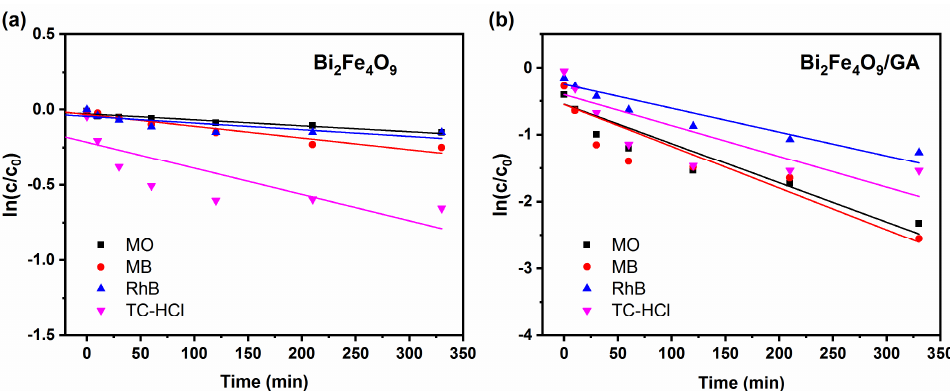
Figure 5. Kinetic fitting results of the dye and drug degradation over ( a ) the Bi 2 Fe 4 O 9 powder and ( b ) the Bi 2 Fe 4 O 9 /GA composite.